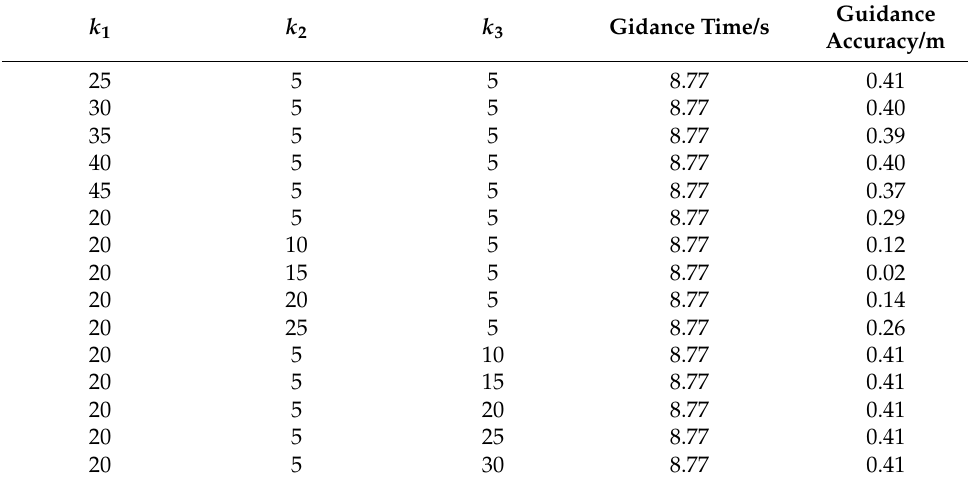
Table 3. Performances of different parameters with constant maneuver.